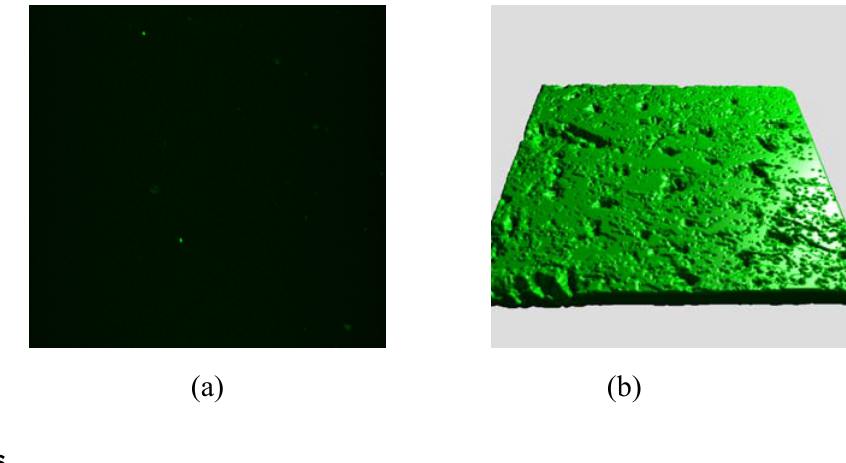
Figure 10. Confocal fluorescence microscopy images (magnification 63X) of cp Ti ( a ) and Oregon Green-labeled gelatin-coated Ti (isosurface mode, b